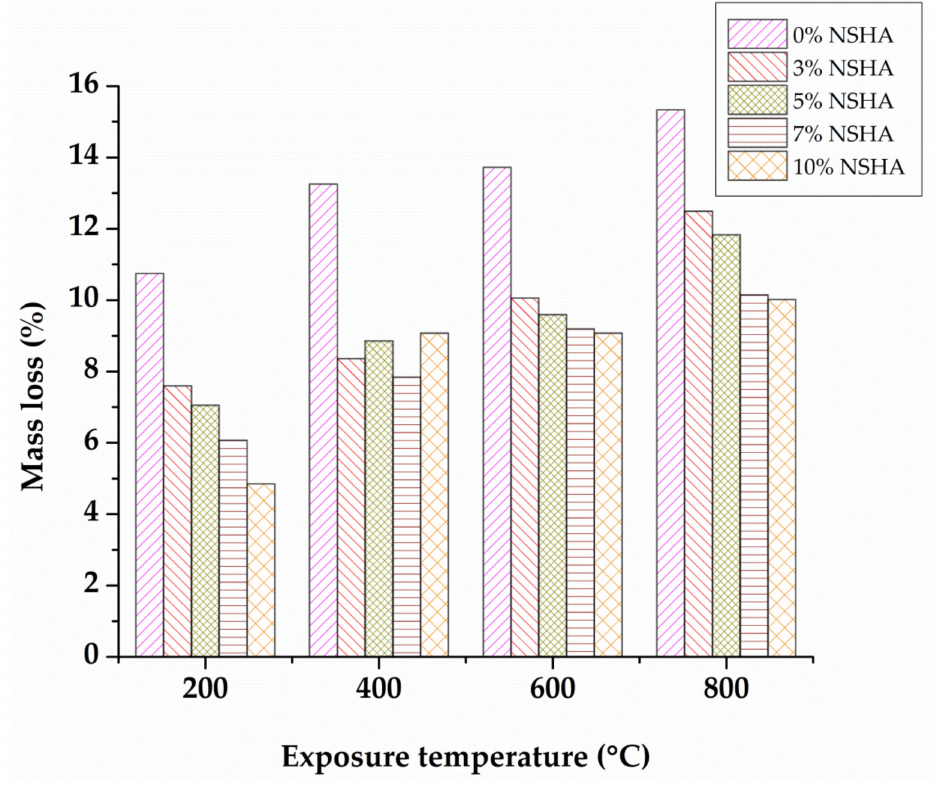
Figure 4. Mass loss versus temperature for OPC and NSHA concrete cured for 7